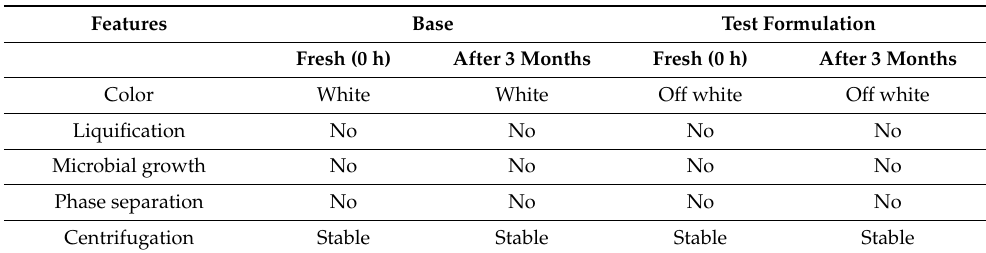
Figure 4. Globule shape of freshly prepared base ( A ) and test ( B ). 2.7. Electrical Conductivity A rise in electrical conductivity in both the placebo and test formulations was rec- orded. This increase in electrical conductivity was more noticeable in both formulations at high temperatures and high RH (40 ± 1 °C and 40 ± 1 °C + 75 ± 1% RH), but it was not statistically significant ( p > 0.05). The result is depicted in Figure 5 for the placebo and plant extract formulations.